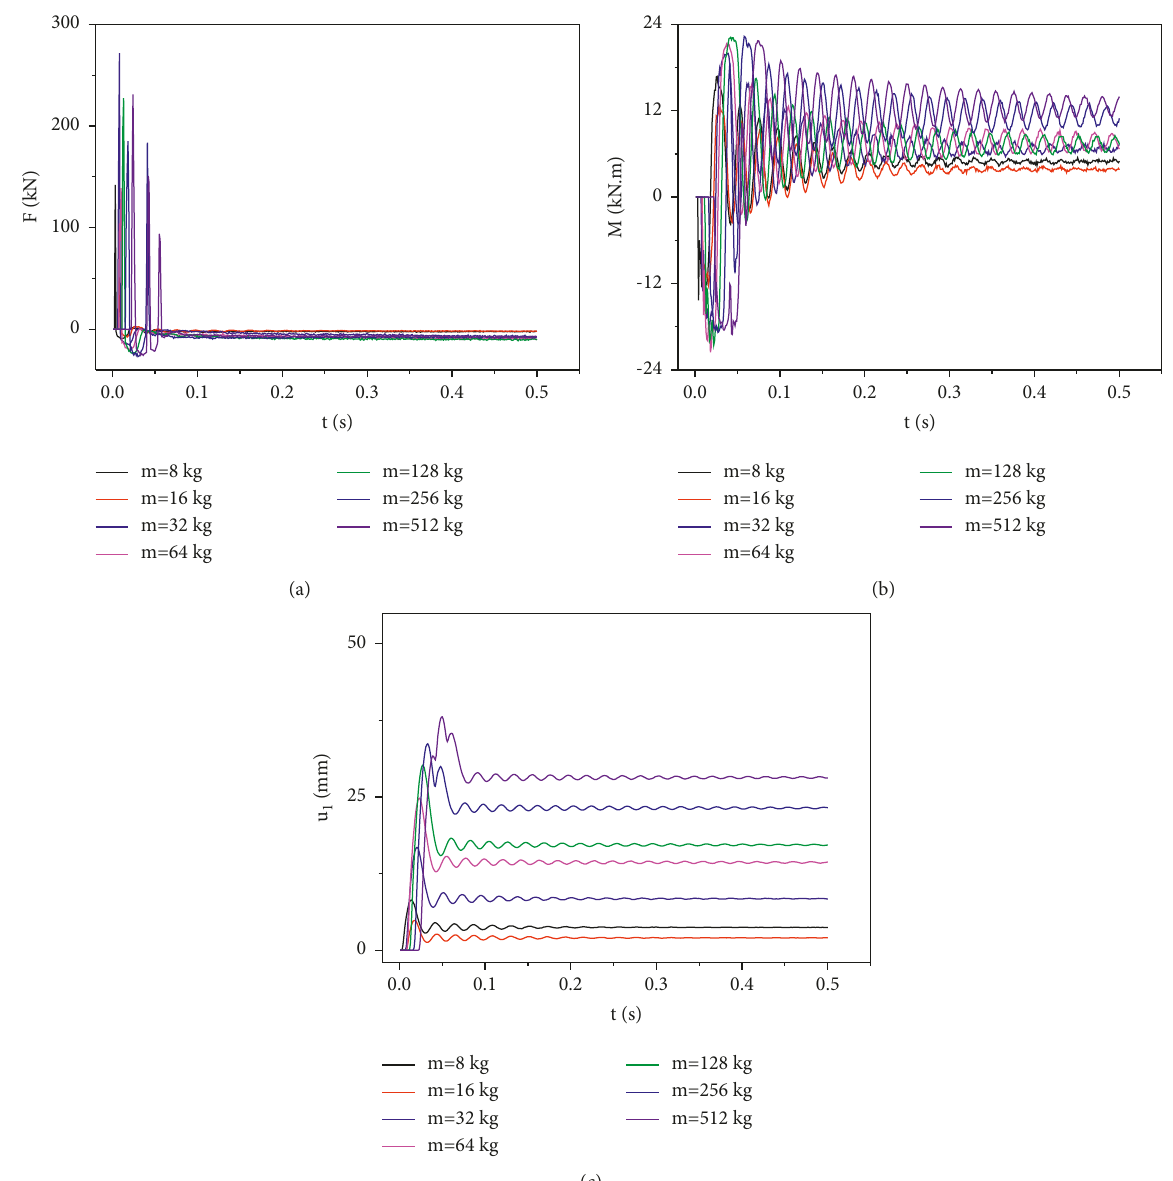
Figure 13: Dynamic response when Ek � 1.28kJ. (a) F- t ; (b) M- t ; (c) u1- t